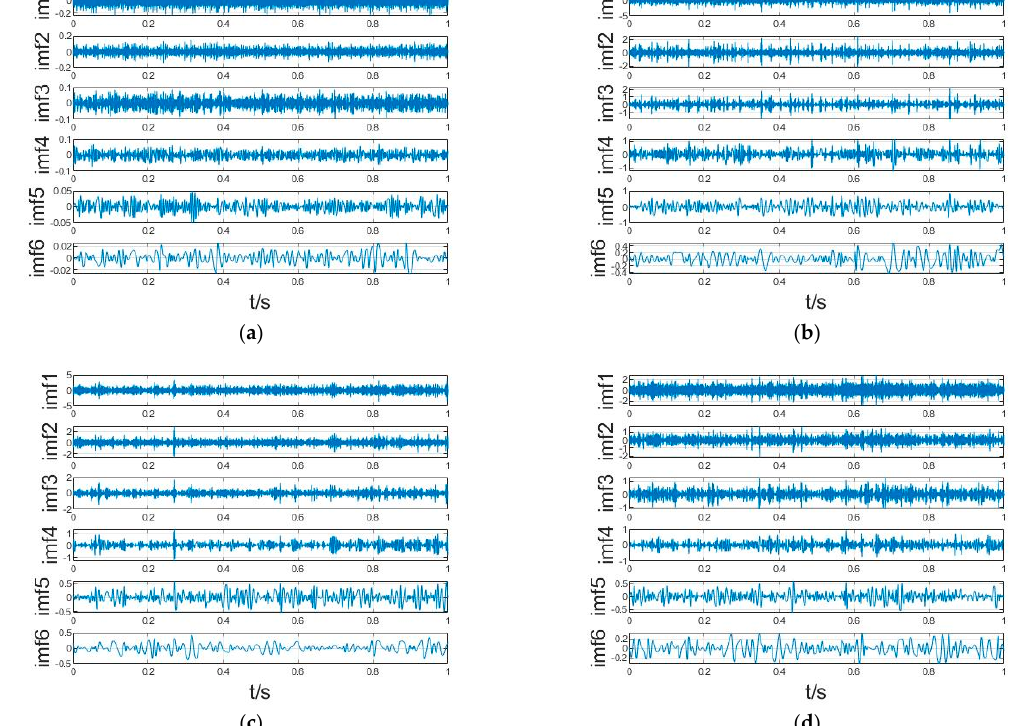
Figure 9. The EMD of the pump volute tongue. ( a ) normal operation. ( b ) incipient cavitation. ( c ) cavitation. ( d ) severe cavitation.